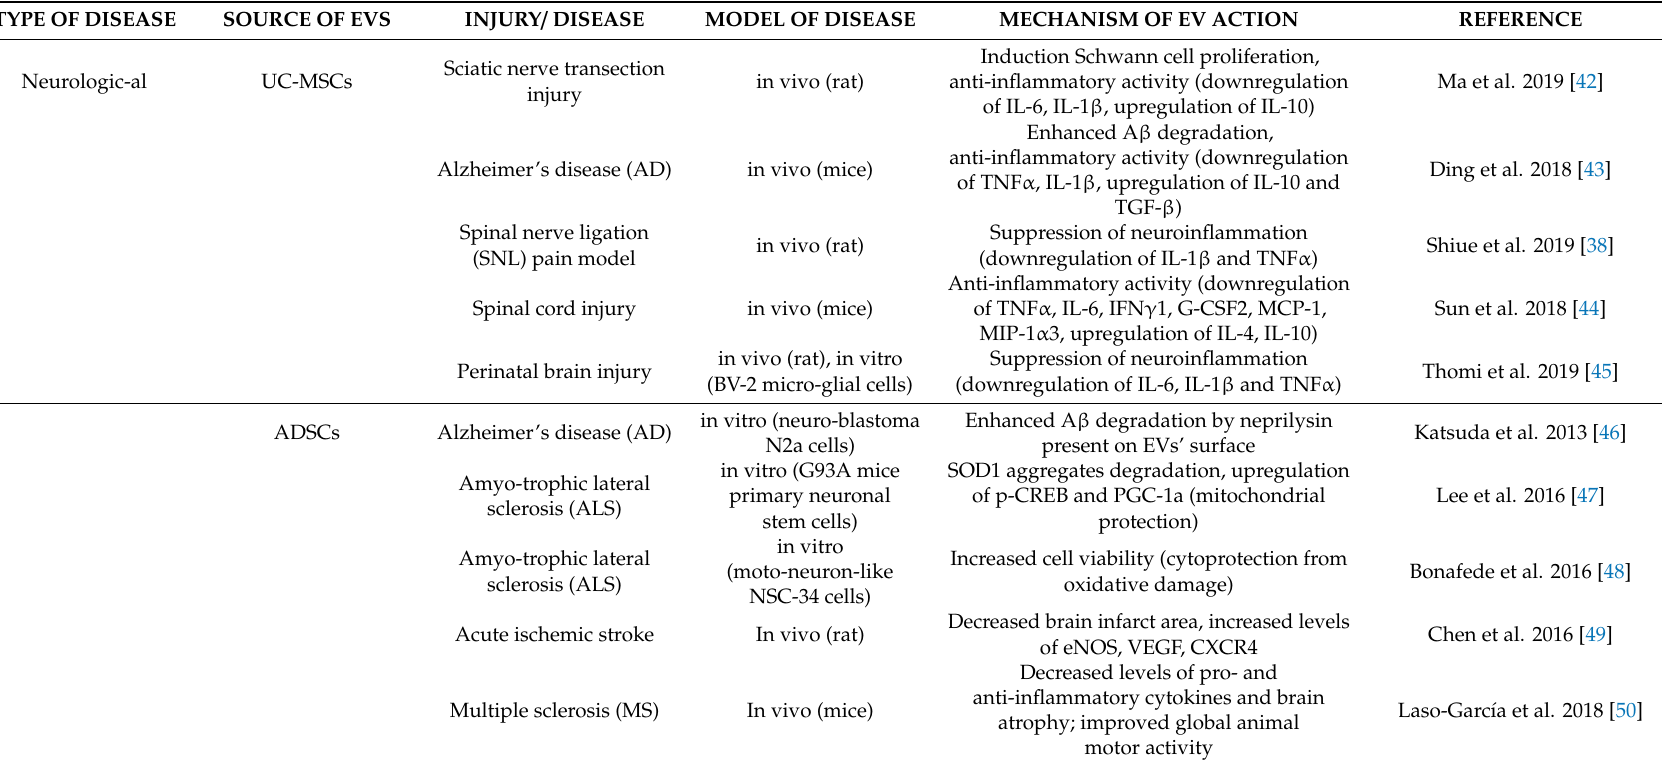
Table 1. Possible applications of adipose tissue (ADSCs) and umbilical cord (UC-MSCs) extracellular vesicles in tissue